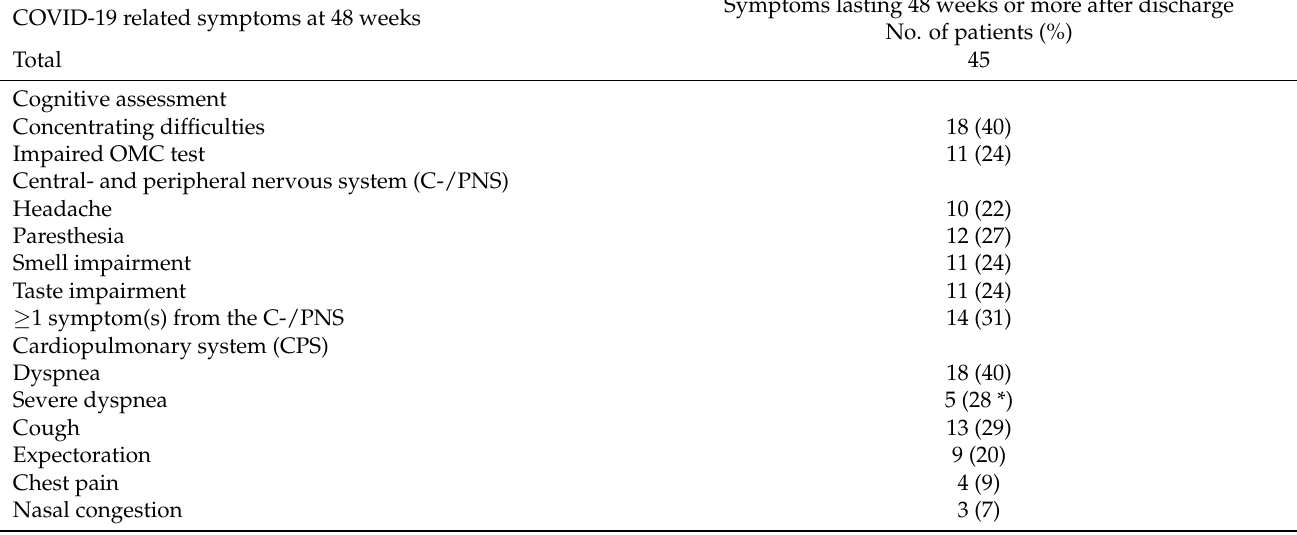
Table A2. Reported new or worsened symptoms at 48 weeks after